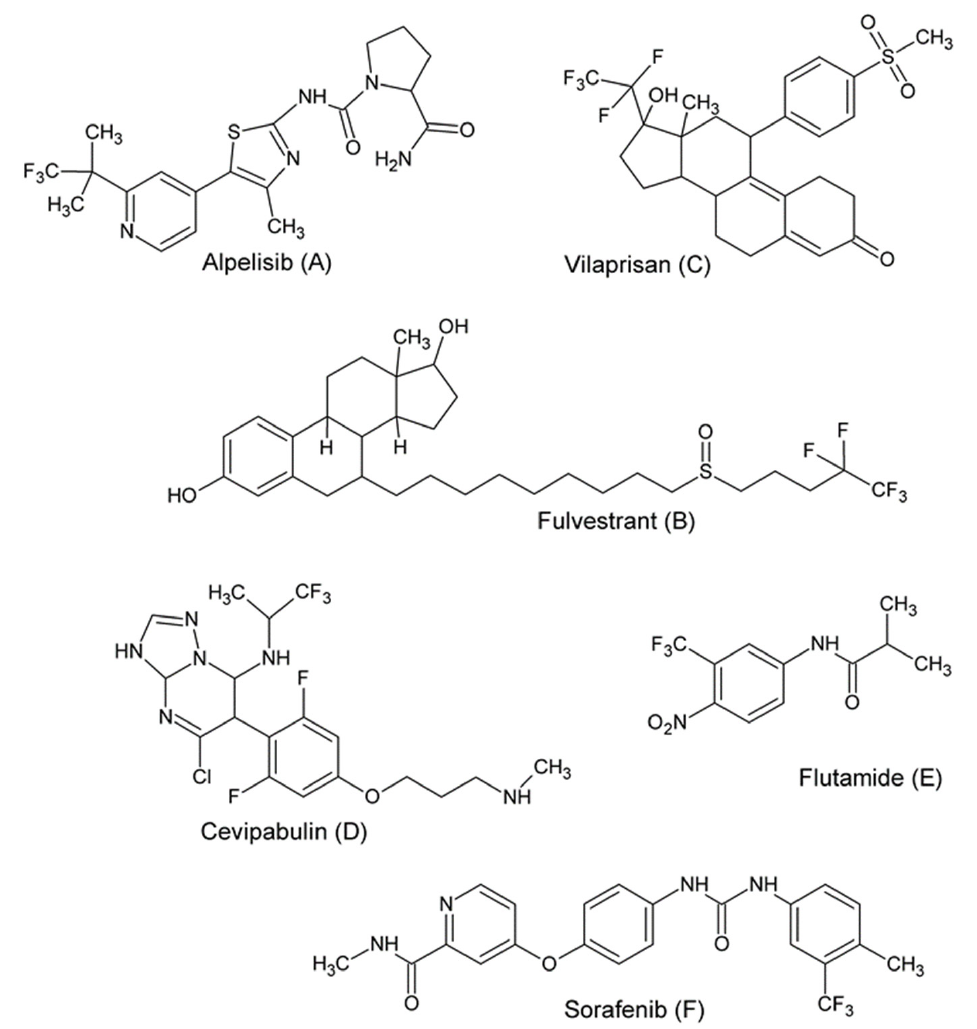
Figure 1. Drugs with a trifluoromethyl substituent used as anticancer agents: ( A ) Alpelisib; ( B ) Fulvestrant; ( C ) Vilaprisan; ( D ) Cevipabulin; ( E ) Flutamide; ( F ) Sorafenib.